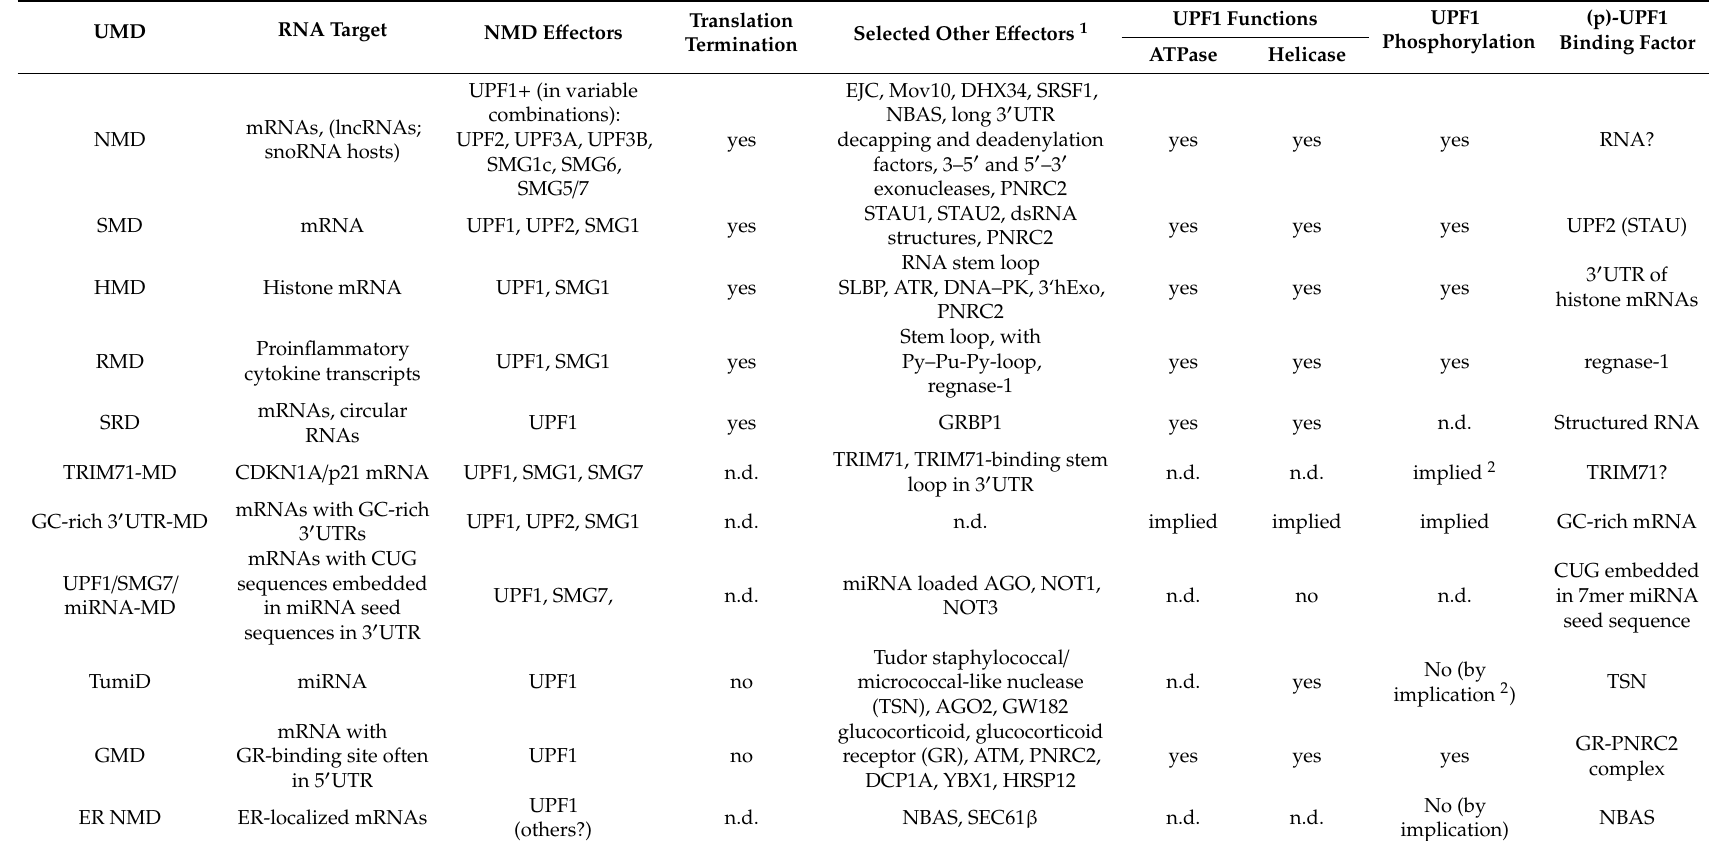
Table 1. Features and requirements of UPF1-mediated RNA decay